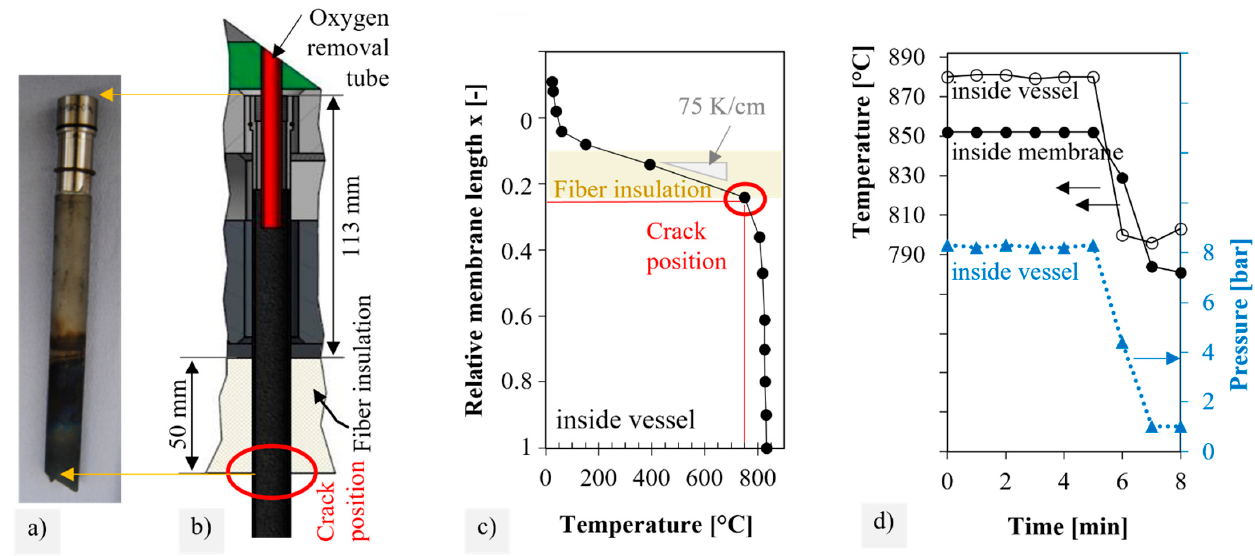
Figure 2. Typical fracture position ( a ) as photograph or ( b ) as sketch visualizing the mounted membrane in the module flange. ( c ) Axial temperature gradient inside membrane during permeation operation; ( d ) temperatures and pressures during emergency shutdown (t = 5 min).